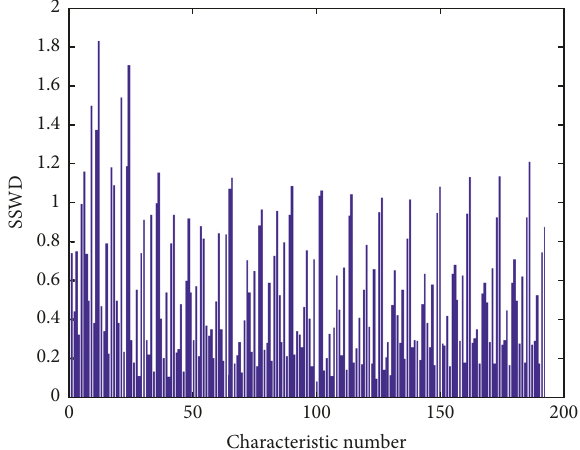
Figure 27: The SSWD of 192 statistical characteristics of training samples.